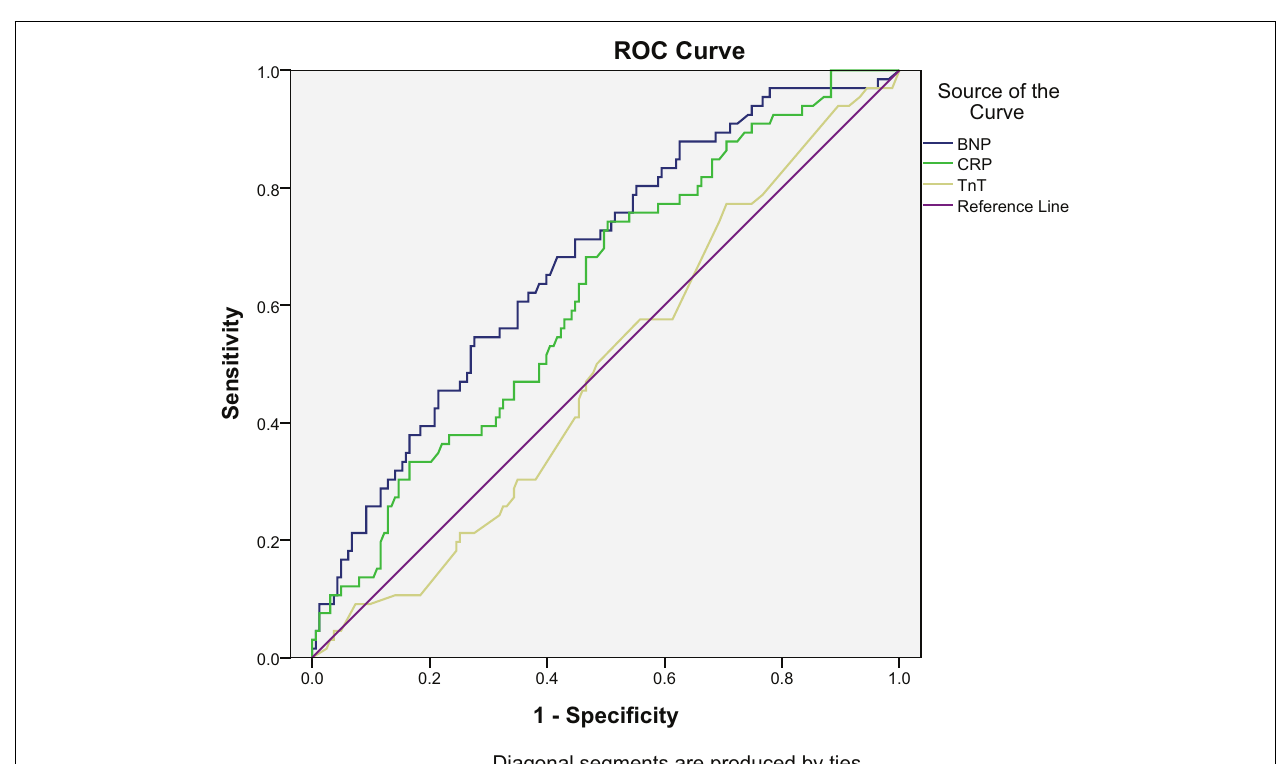
FIGURE 3 | ROC for all-cause mortality at 2years: BNP, CRP, andTnT .